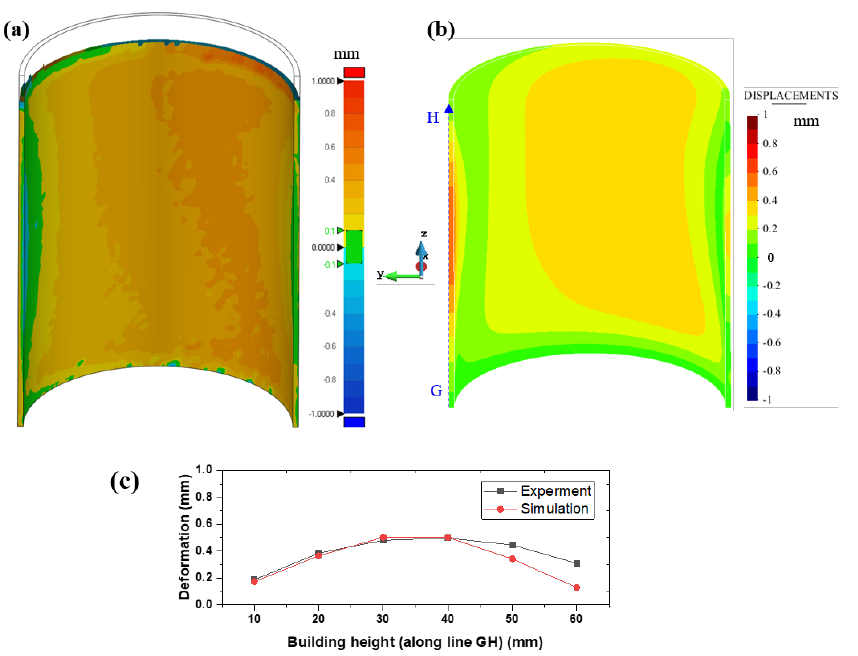
Figure 8. Semi − cylindrical (SC2) part: comparison between the ( a ) experimental and ( b ) simulated displacement distributions. ( c ) The deformation distribution along the line GH, located at the edge of the build.